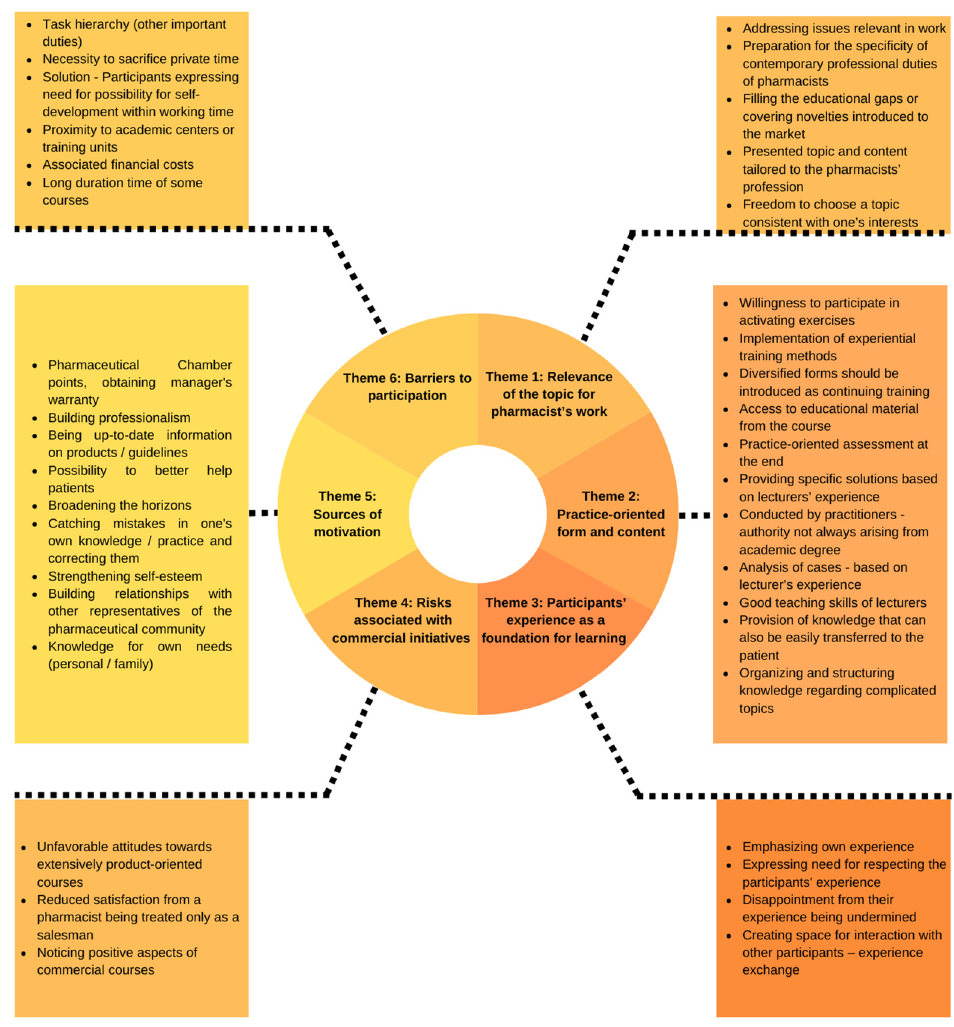
Figure 1. Summary of key findings.